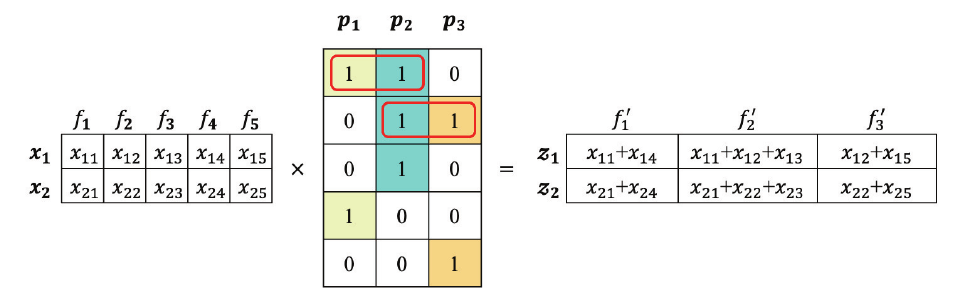
Figure 1. An explanation of specific and common features of feature